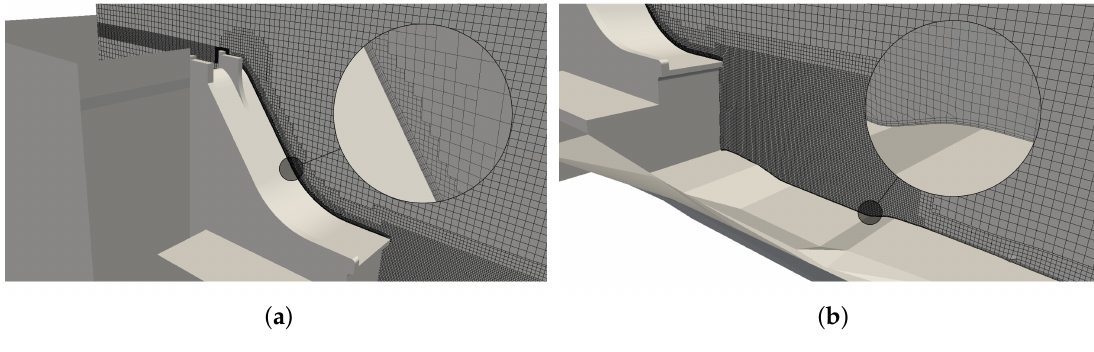
Figure 2. Overview of the hex-dominant unstructured finite-volume grid employed in the simulations: ( a ) detail of the grid on the main spillway surface; ( b ) detail of the grid on the dissipation